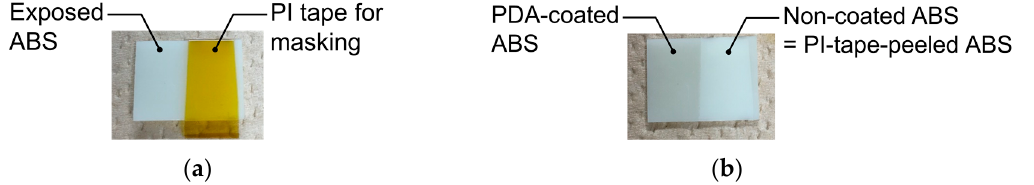
Figure 2. Photographs of ABS samples with a masking using polyimide (PI) tape ( a ) before PDA coating and ( b ) after PDA coating for 24 h.